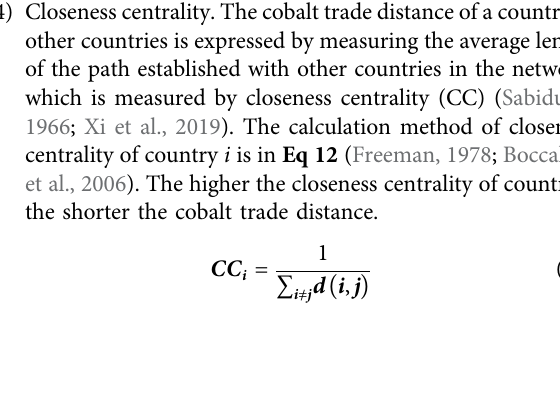
Frontiers in Energy Research |